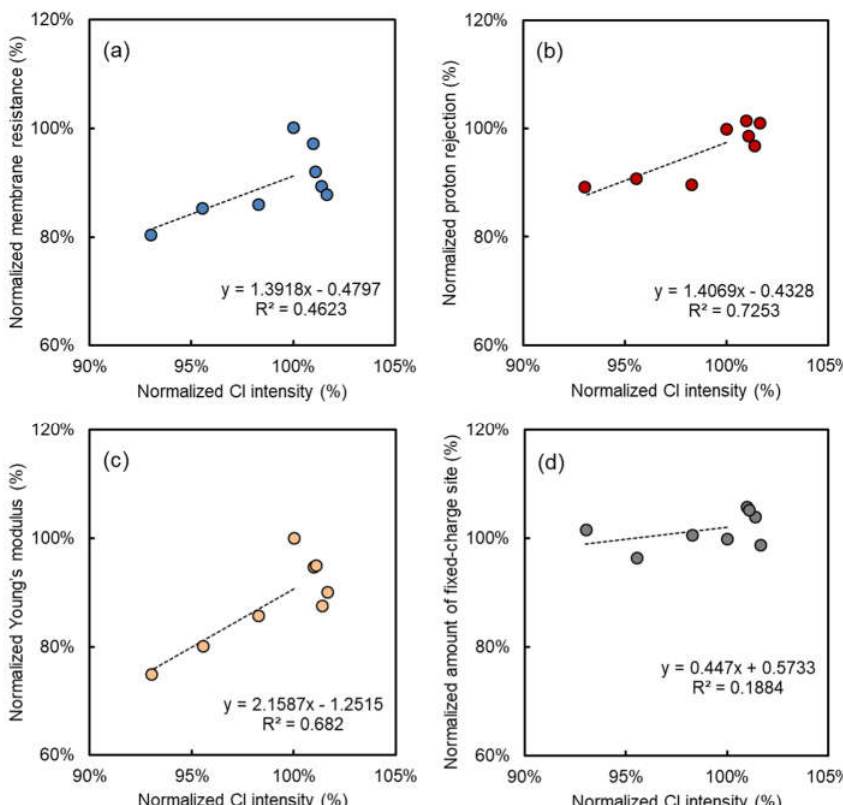
Figure 6. Correlation between electrical and mechanical properties and normalized chloride intensity after NaOH immersion at 40 °C: normalized ( a ) electrical resistance, ( b ) proton rejection, ( c ) Young’s modulus, and ( d ) amount of fixed-charge sites.